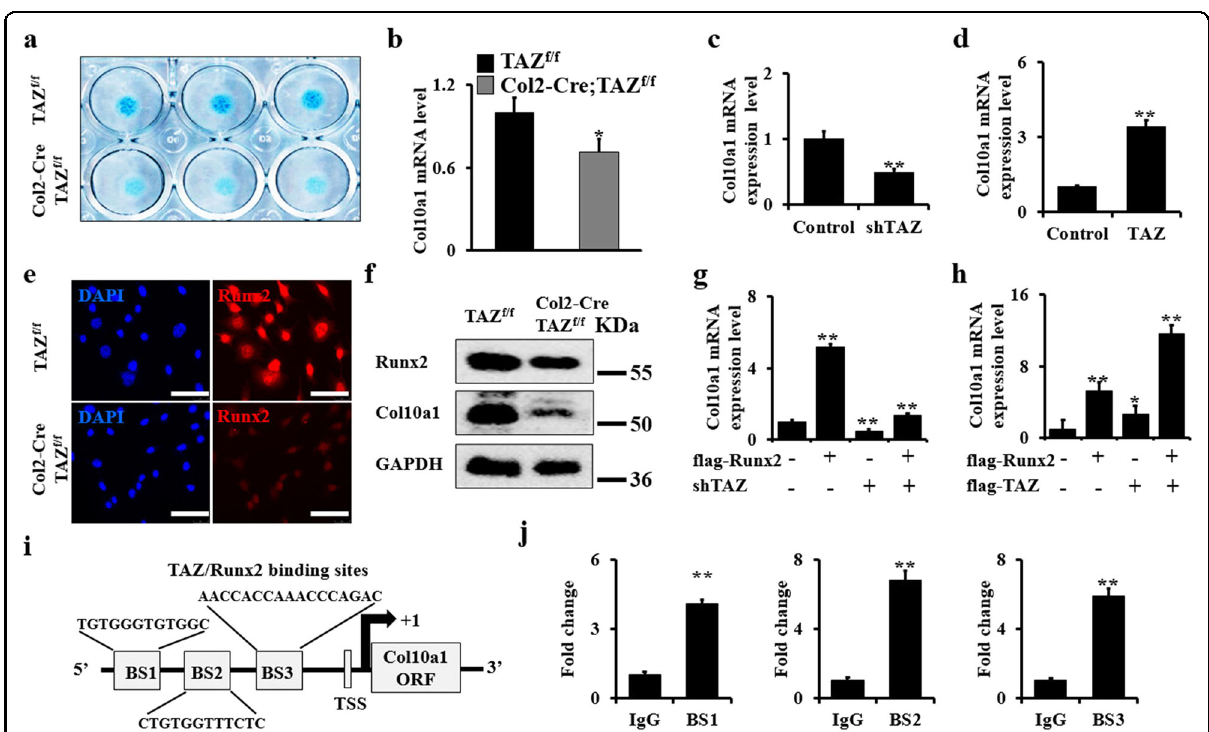
Fig. 6 Deletion of TAZ blocks chondrocyte maturation via inhibiting Col10a1 expression. a Micromass culture with primary chondrocytes from Col2-Cre;TAZ f/f mice and controls. After cultures of 7 days, the macromass cultured chondroctyes were stained with Alcian blue as shown. b qRT-PCR analysis of Col10a1 in primary chondrocytes of Col2-Cre;TAZ f/f mice and controls. c , d qRT-PCR analysis from silenced- and overexpressed-TAZ transduced chondrocytes and controls. e Immuno fl uorescence staining analysis for Runx2 expression in chondrocytes from Col2-Cre;TAZ f/f mice and controls. Scale bars, 25 μ m. f Whole chondrocyte lysates from Col2-Cre;TAZ f/f mice and controls were immunoblotted with antibodies against Runx2, Col10a1, and GAPDH, respectively. g , h Col10a1 expression in chondrocytes after manipulation with Runx2, shTAZ, or TAZ as shown. i Schematic diagram of TAZ/Runx2-binding sites in the Col10a1 promoter (BS binding site; TSS, transcription start site). j ChIP assay. Co-occupation of TAZ/Runx2 in the Col10a1 promoter. The experiment was independently repeated for three times. Error bars were the means ± SEM of triplicates from a representative experiment. * P < 0.05, ** P <